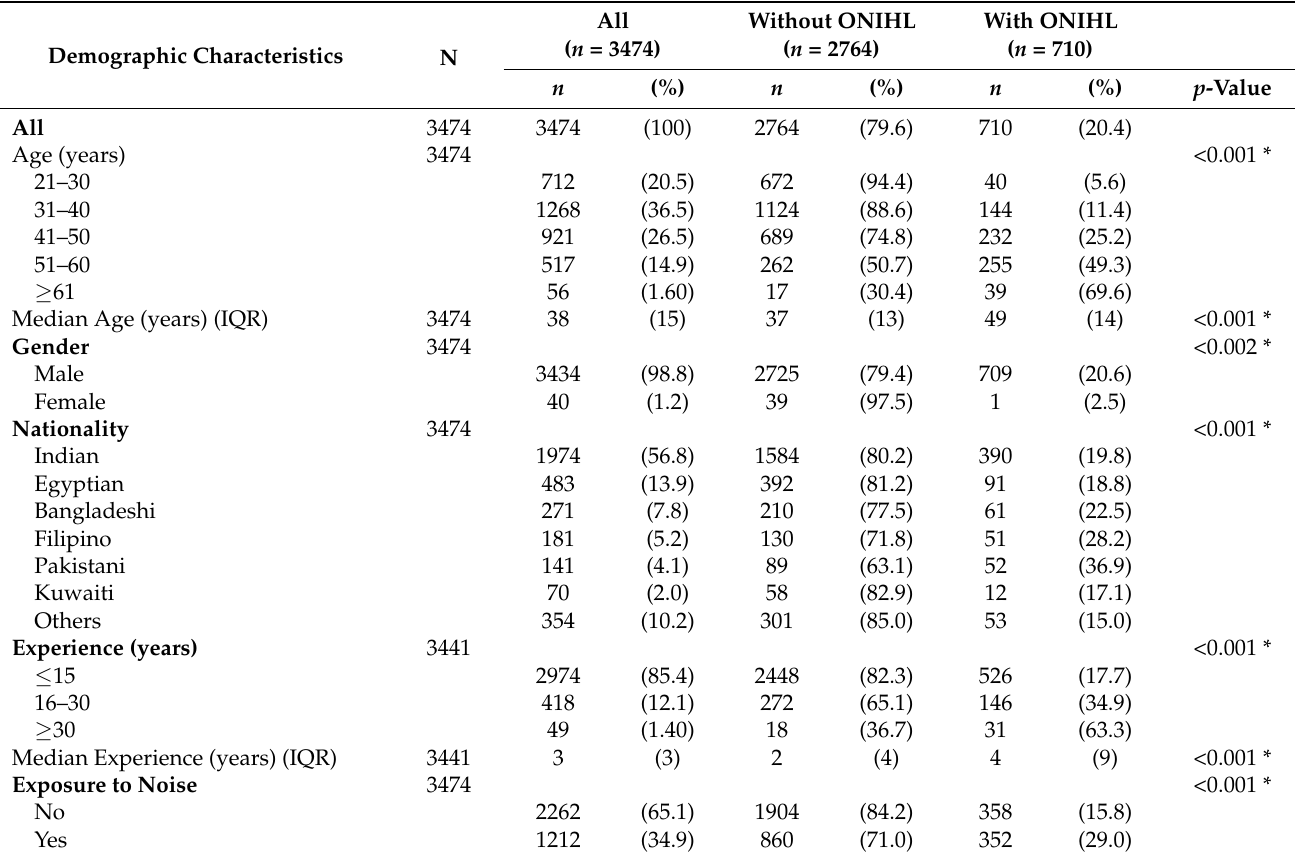
Table 1. Baseline characteristics of industrial workers according to occupational noise-induced hearing loss status.